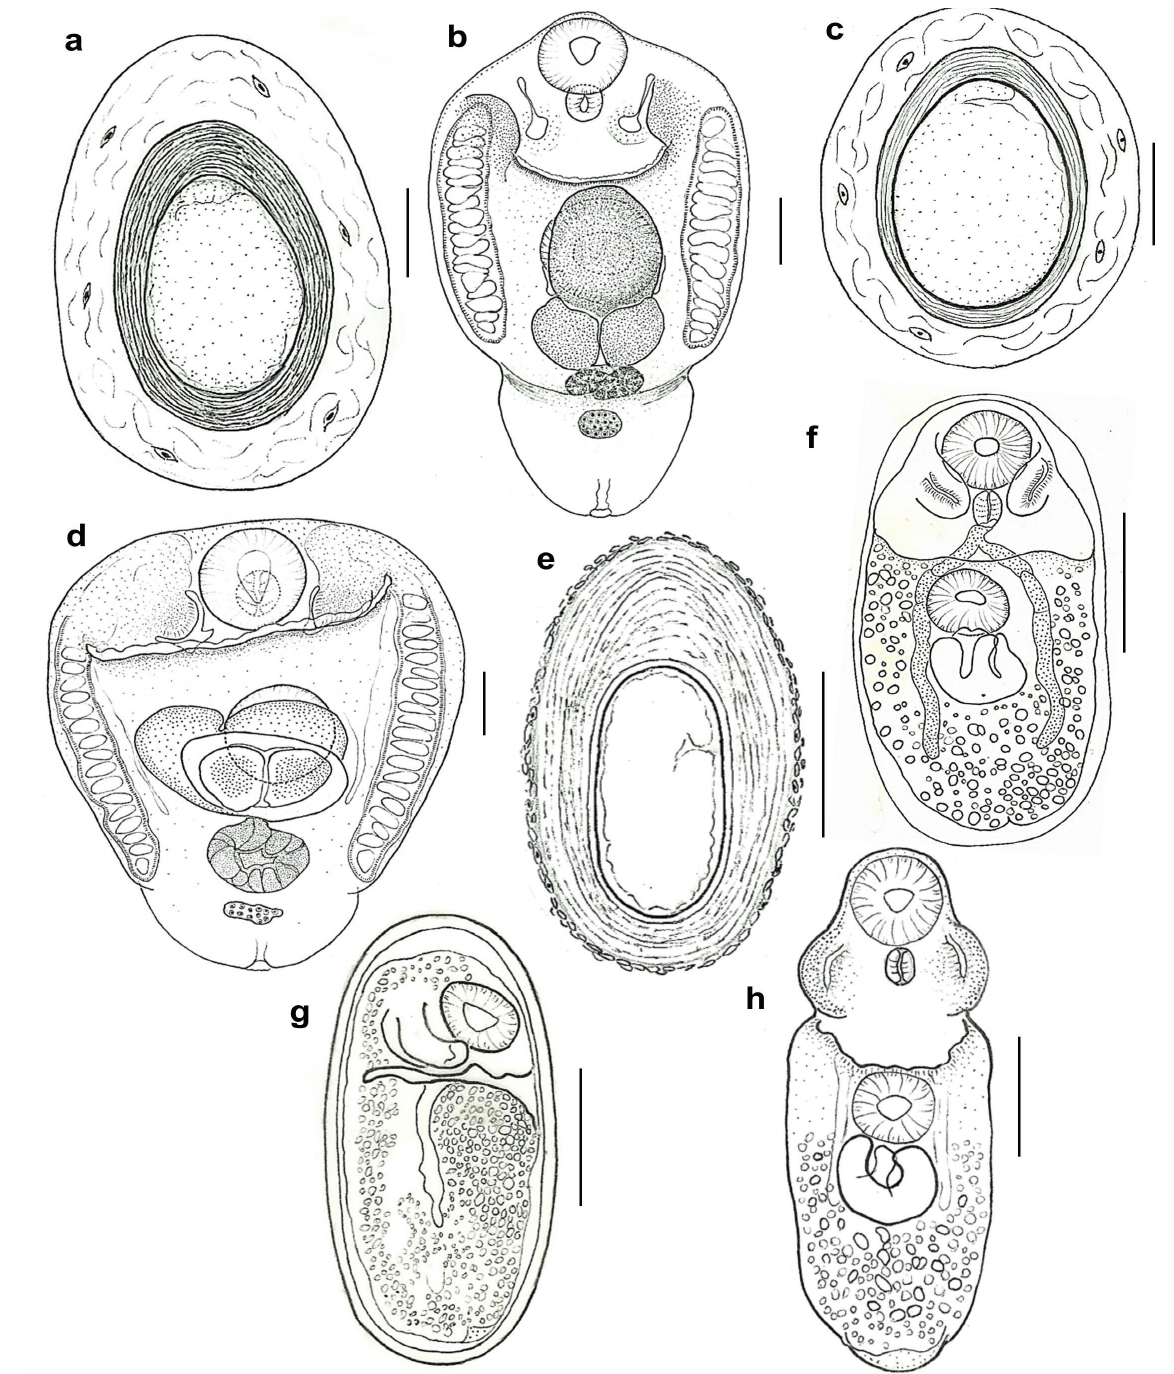
Figure 1 - Strigea sp. 1. ( a ) cyst; ( b ) whole-mount of excysted larva, ventral view. Strigea sp. 2. ( c ) cyst; ( d ) whole-mount of excysted larva, ventral view. Strigea sp. 3. ( e ) cyst; ( f ) larva encysted, ventral view; ( g ) larva encysted, lateral view; ( h ) whole- mount of excysted larva, ventral view. Scale bars: b , d , f , g , h = 50 μm; a , c , e = 150